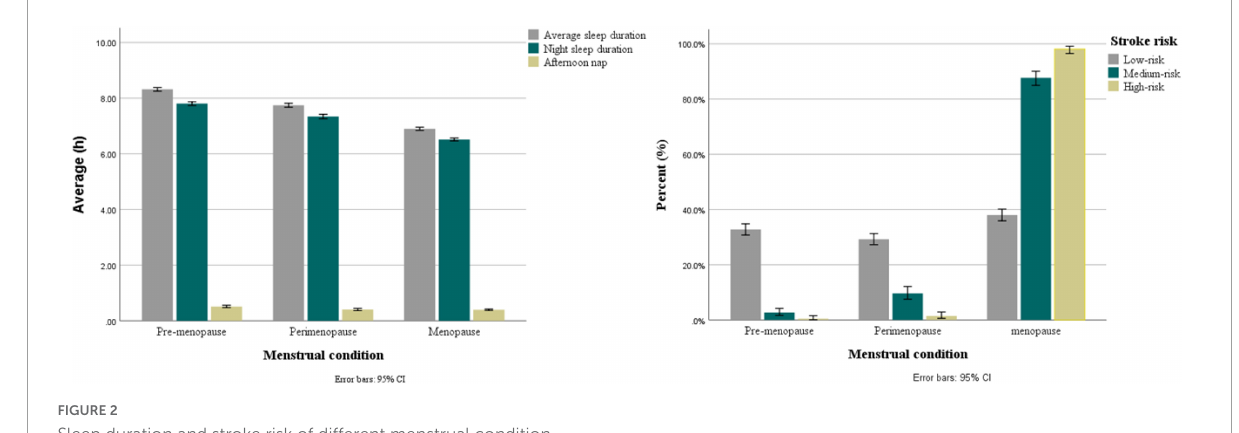
FIGURE2 Sleep duration and stroke risk of different menstrual condition.